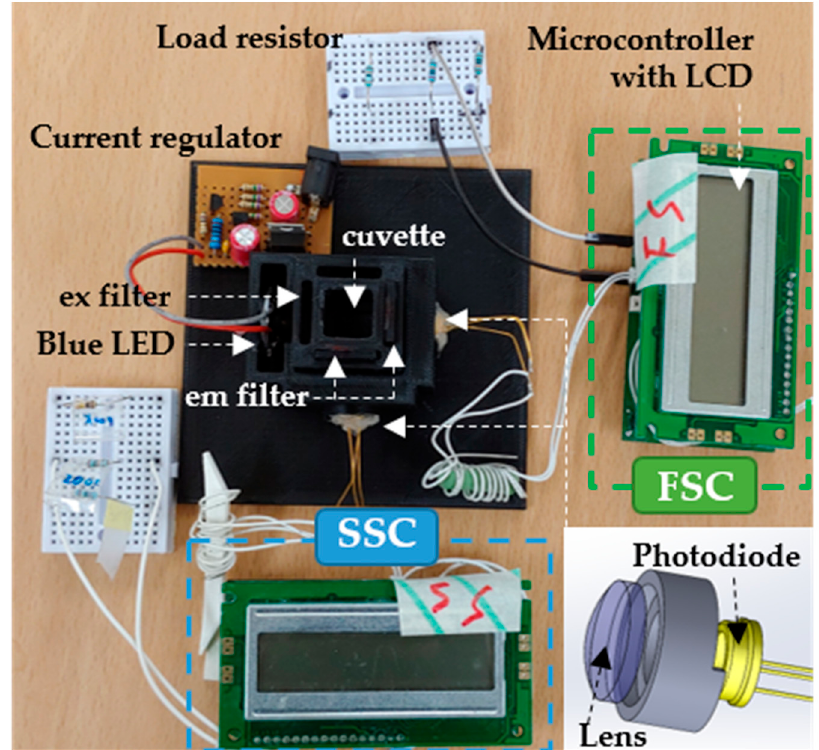
Figure 2. Proposed fluorescence detection system. Light-emitting diode (LED) with specific wavelength excites the HeLa cells sample through the excitation filter (ex filter). Emission light including side scatter (SSC) and forward scatter (FSC) is collected through the emission filter (em filter). Collected light is analyzed and displayed on the liquid crystal display (LCD) module.